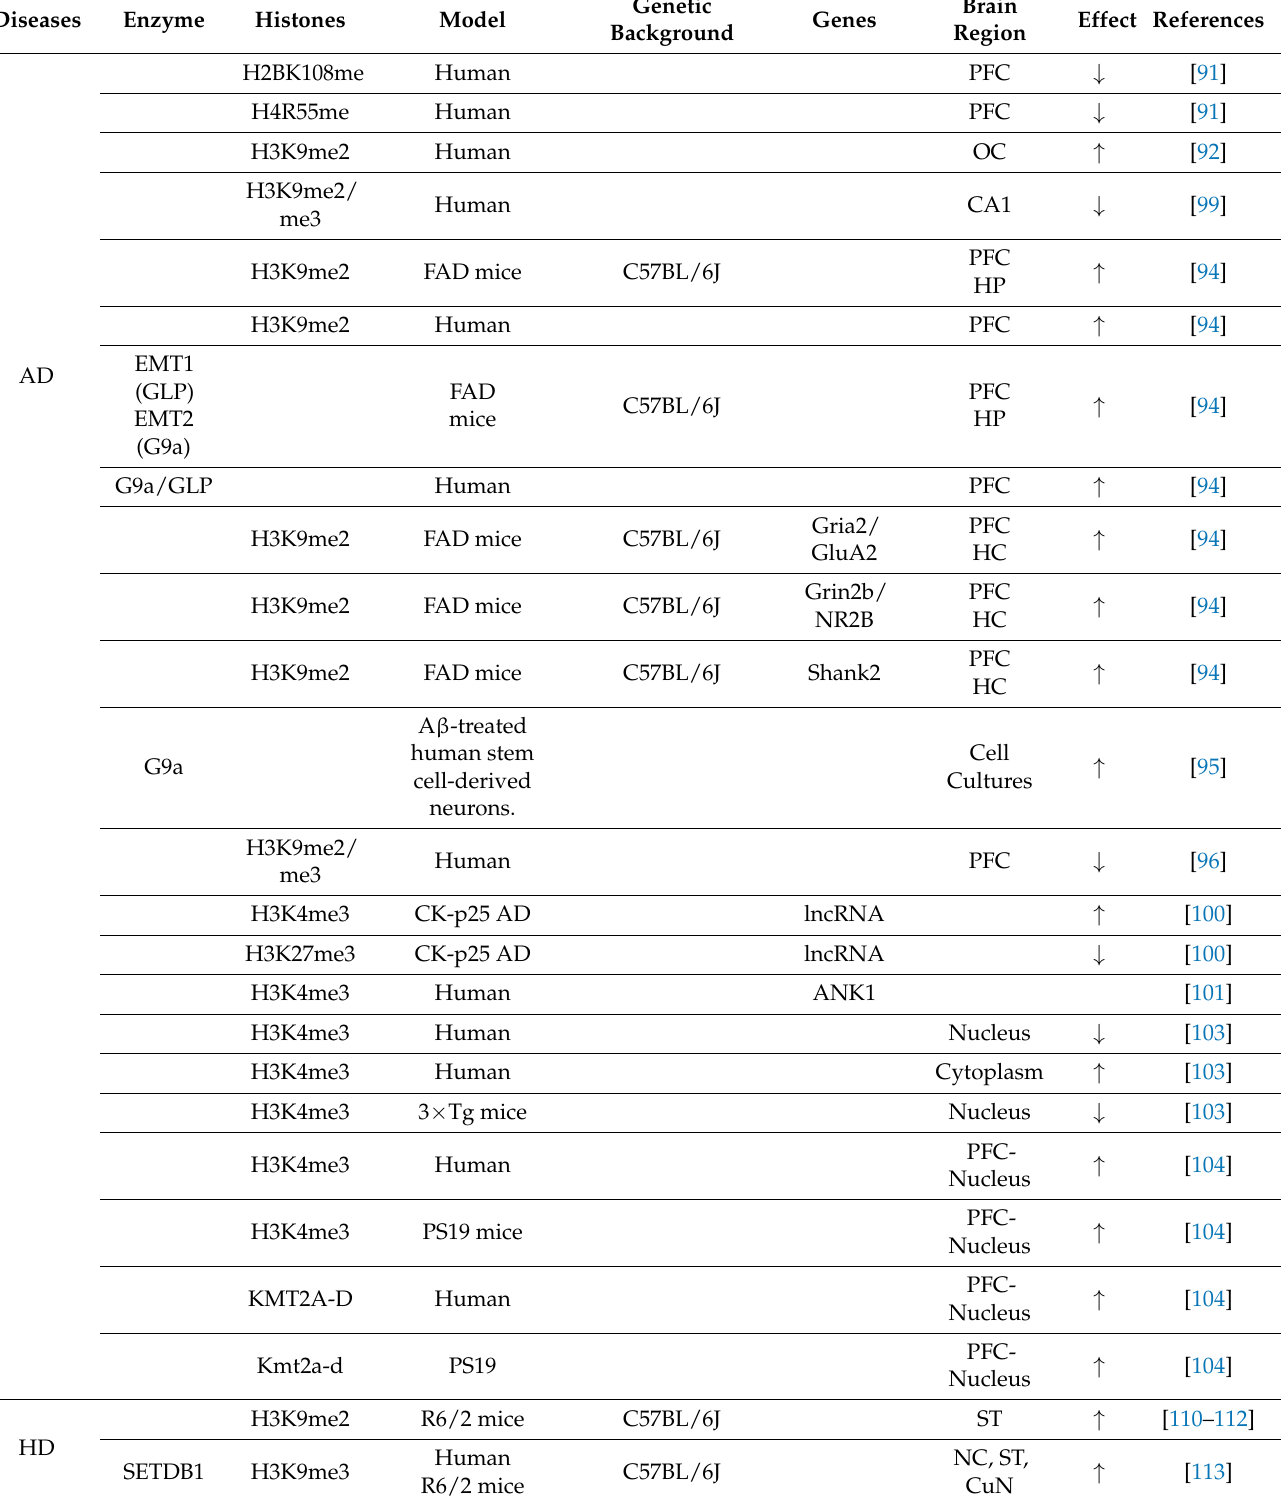
Table 1. Histone methylation defects in neurodegenerative